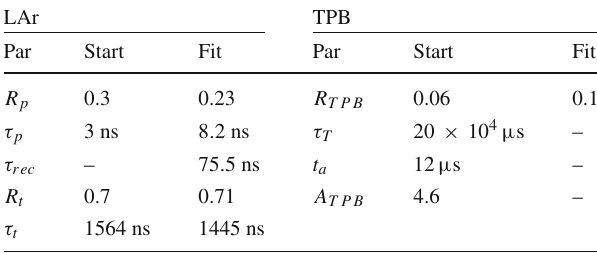
Table1 Startandfitparameters,LArandTPB.Parameteruncertainties are not given, as explained in the text